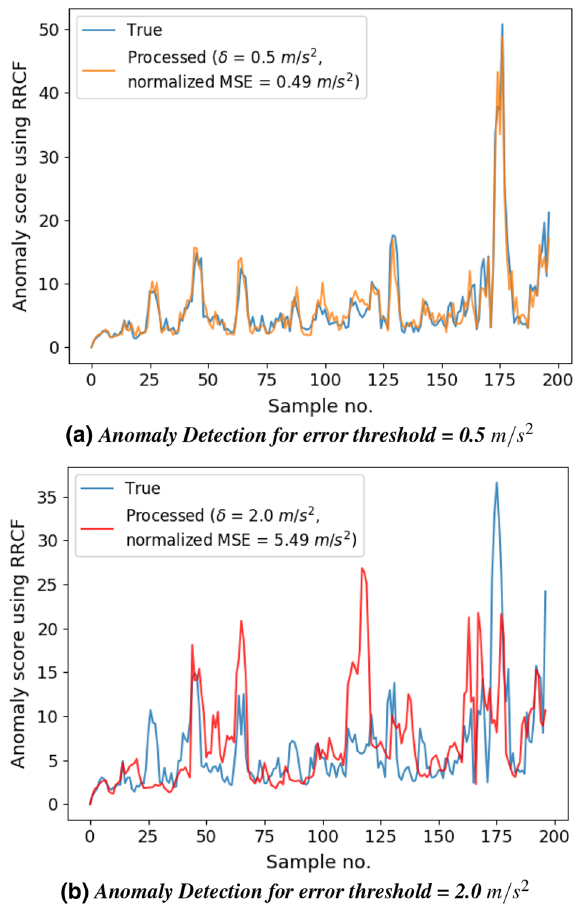
Figure 4. Anomaly detection for various error thresholds. For threshold up to 1.2, the accuracy of the anomaly detection application is not affected.